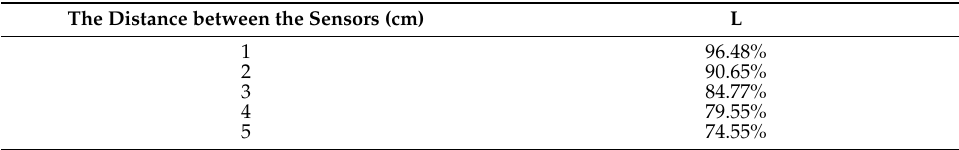
Table 5. The calculated information